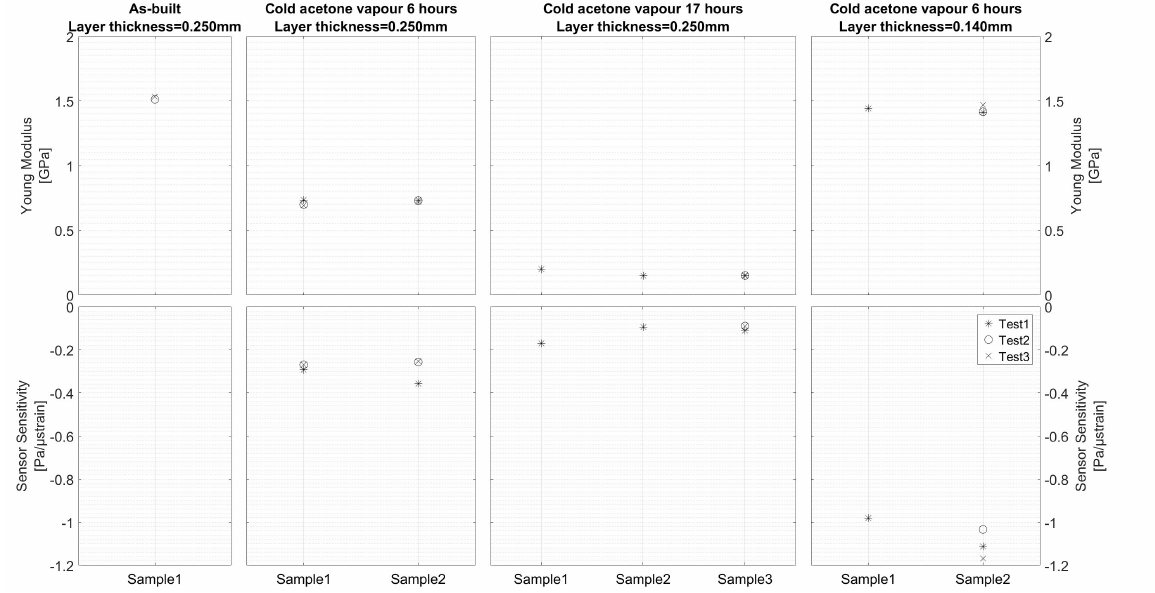
Figure 5. Comparison of cold acetone vapor after-treatment processes on Young Modulus ( top ) and strain measurement system performance ( bottom ) of ABS printed